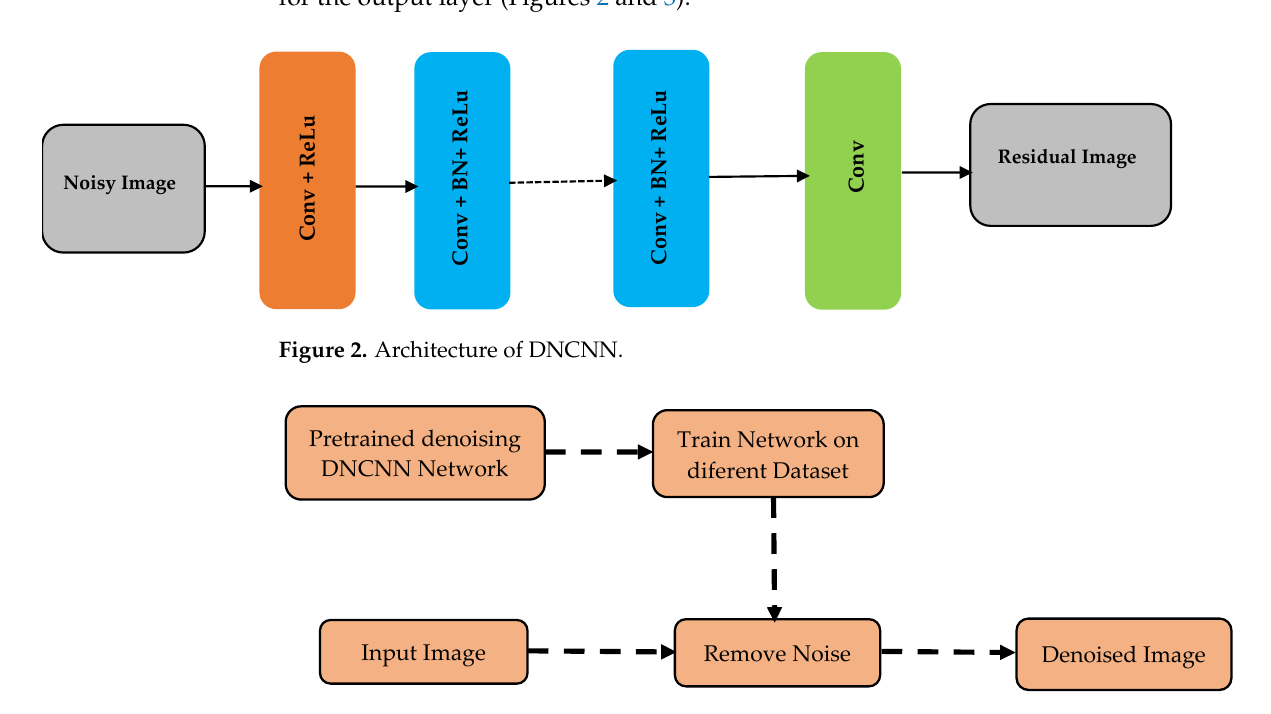
Figure 3. Proposed DNCNN workflow for image enhancement. Algorithm 3 : Algorithm of the proposed DNCNN Algorithm 5 : Algorithm of OTSU Thresholding